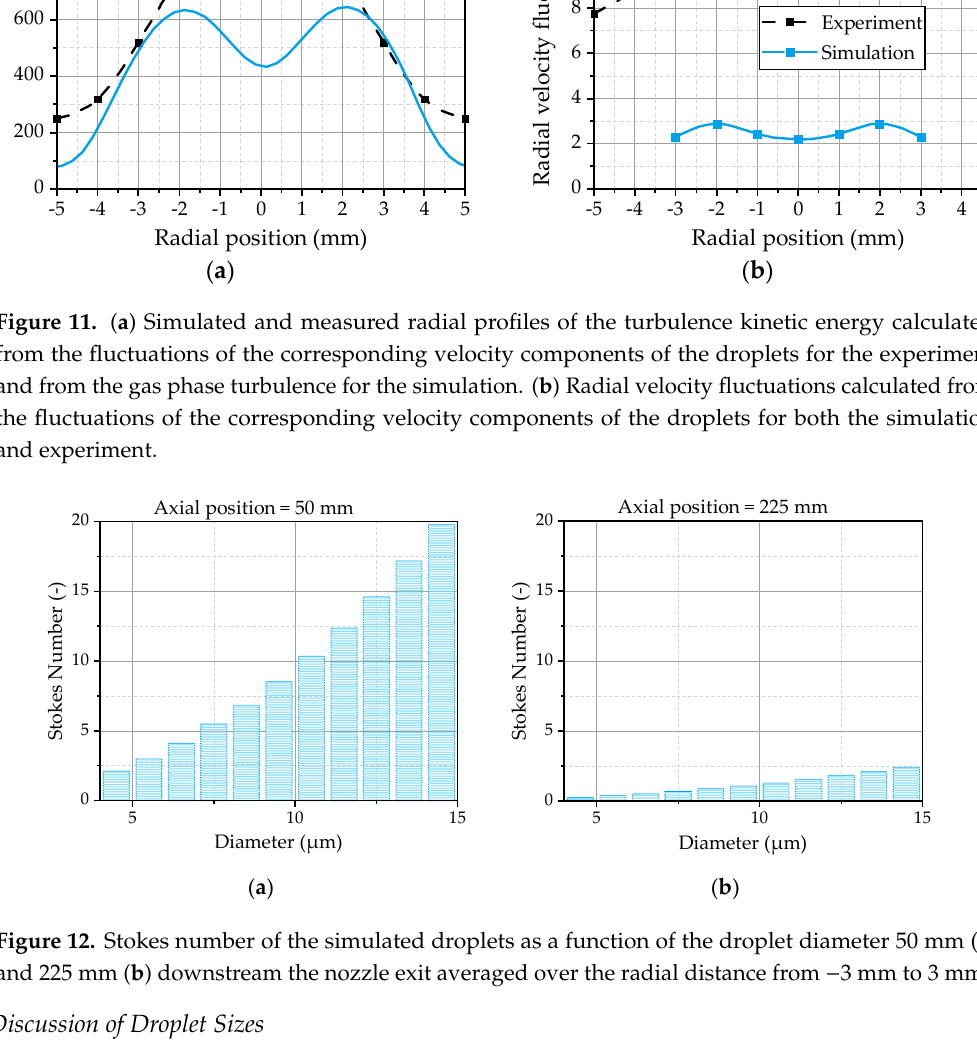
( c ) Figure 13. Arithmetic diameter, Sauter mean diameter and diameter at the 90% volumetric quantile in the radial direction for OP 1 ( a ), OP 2 ( b ) and OP 3 ( c ).